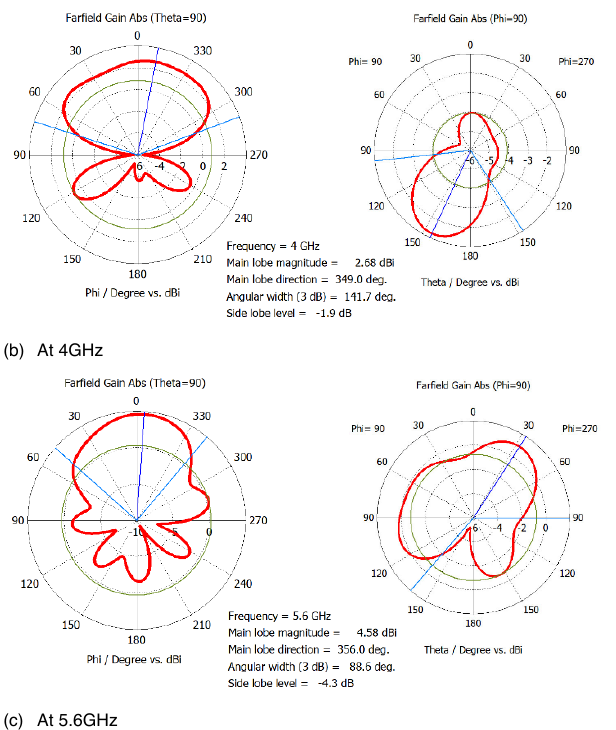
FIGURE 4. 2D radiation of the Vivaldi antenna. The 2D radiation patterns of the proposed antenna at the E plane (on the left) and H plane (on the right) are presented in Figure 4. The antenna gets a good gain of 3.76dB, 2.67dB, and 4.58dB at 2.4GHz, 4GHz, and 5.6GHz, respectively. The simulation radiation efficiency of the antenna has achieved a rather high value of over 74% at 2.4GHz, nearly 80% at 4GHz, and 76% at 5.6GHz.